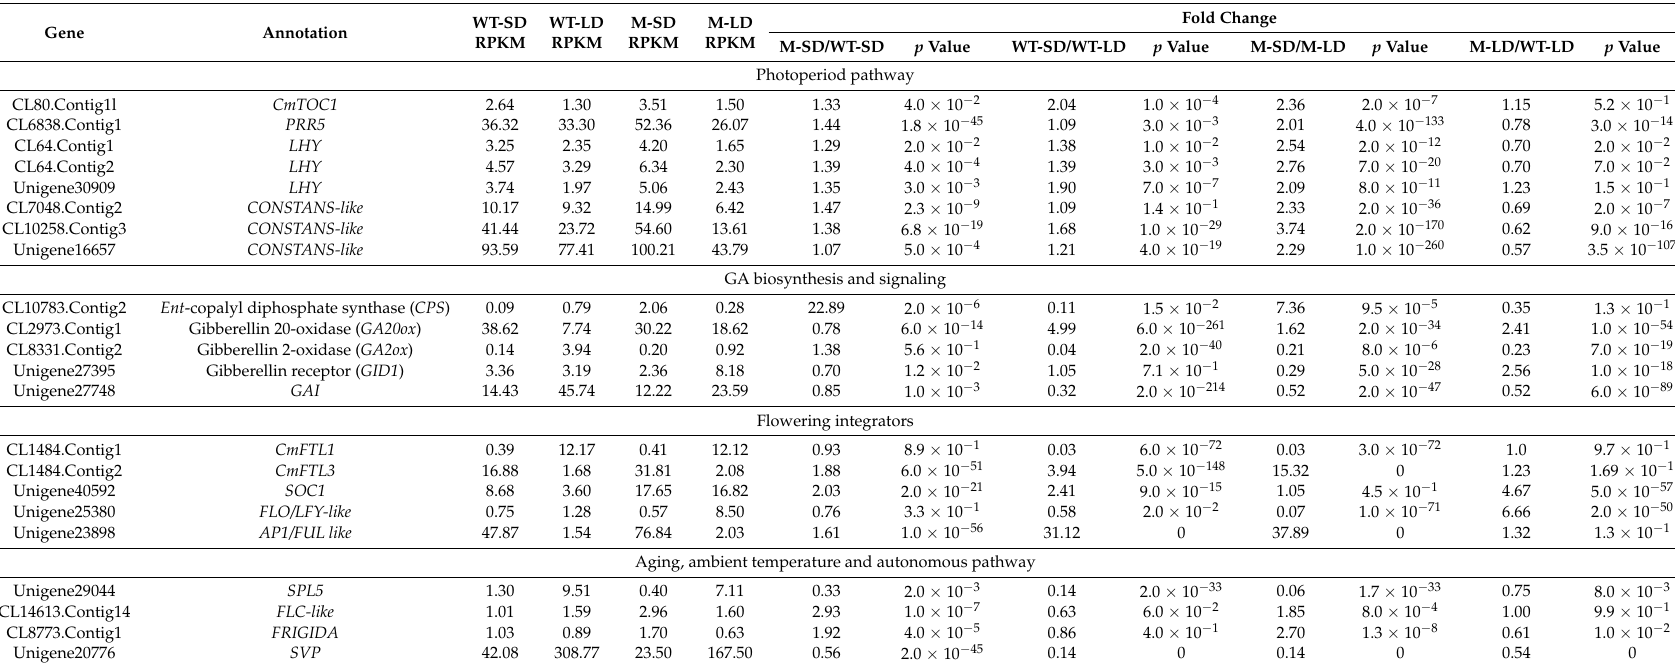
Table 2. Differentially transcribed flowering time-related genes detected in ‘Jinba’ WT and M plants grown under LD or SD. Gene